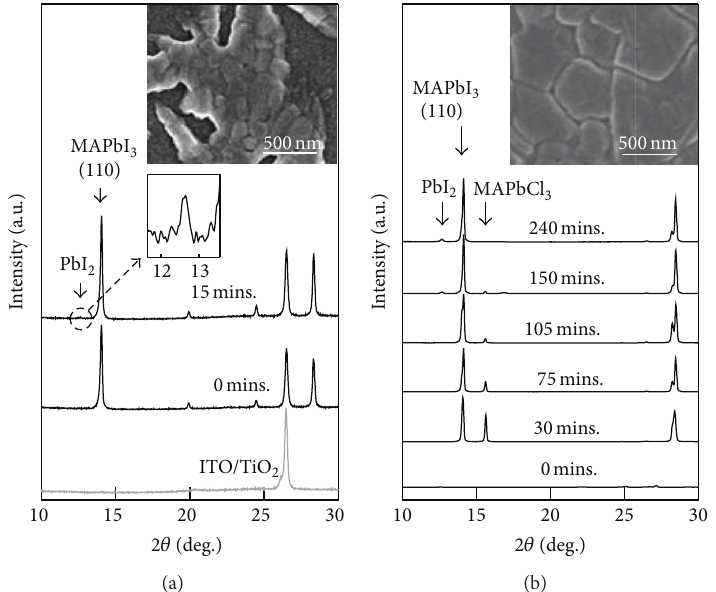
Figure 5: (a) XRD data for tri-iodide perovskite annealed at 100 ∘ C with varying annealing times. Inset shows SEM of perovskite film annealed for 15mins at 100 ∘ C. (b) XRD data for mixed halide perovskite annealed at 100 ∘ C with varying annealing times. SEM of perovskite film annealed for 150mins at 100 ∘ C. Reproduced from [22] with permission from the Royal Society of Chemistry.